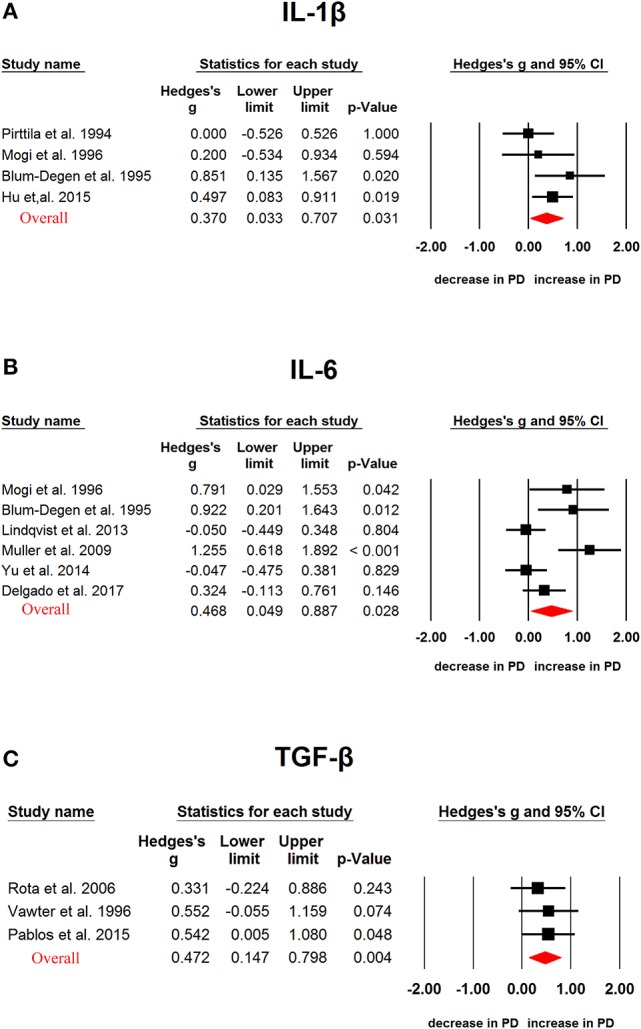
Studies of cerebrospinal fluid IL-1β, IL-6 and TGF-β1 in Parkinson's disease. Forest plot displaying random-effects meta-analysis results of the association between IL-1β (A), IL-6 (B), TGF-β1 (C) and Parkinson's disease. The sizes of the squares are proportional to study weights.